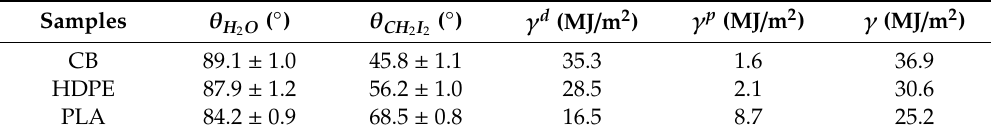
Table 1. Measured H 2 O and CH 2 I 2 contact angles (at 25 ◦ C) and calculated values of surface energy of the used high-density polyethylene (HDPE) and poly (lactic acid) (PLA). CB, carbon black. Samples θ H ( ◦ 2 O